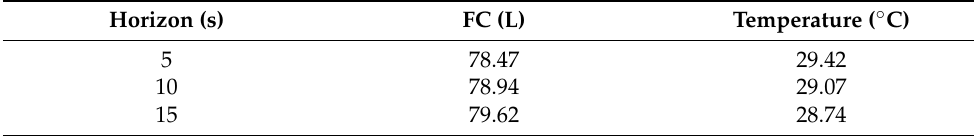
Table 2. Results of PMP-MPC with three prediction horizons in driving cycle